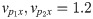
Power spectrum of parkinsonian STN activity as a function of DBS pulse frequency with fstim = 24–28 Hz.A simulation of 40 s is used with νζx = −1.2 mVs and vp1x,vp2x=1.2 mVs and the power spectrum of the STN firing rate is calculated over the time window t = 20–40 s.